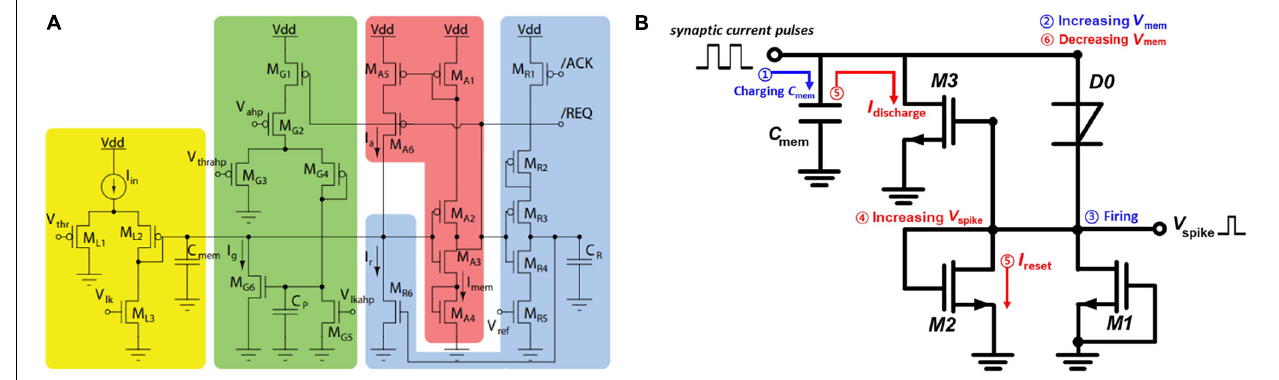
FIGURE 2 | (A) Leaky integrate-and-fire (LIF) neuron circuit based on complementary metal–oxide–semiconductor (CMOS) technology (Indiveri et al., 2011). (B) Integrate-and-fire (IF) neuron circuit using a p-n-p-n diode (Park et al., 2021).